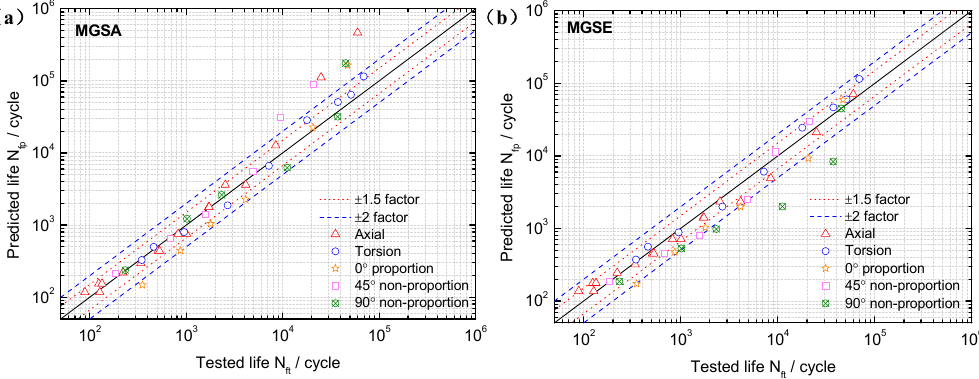
Figure 4. Comparison between tested lives and predicted lives using ( a ) the MGSA model (Equation (10)) and ( b ) the MGSE model (Equation (11)) for TC4 under symmetric loadings.